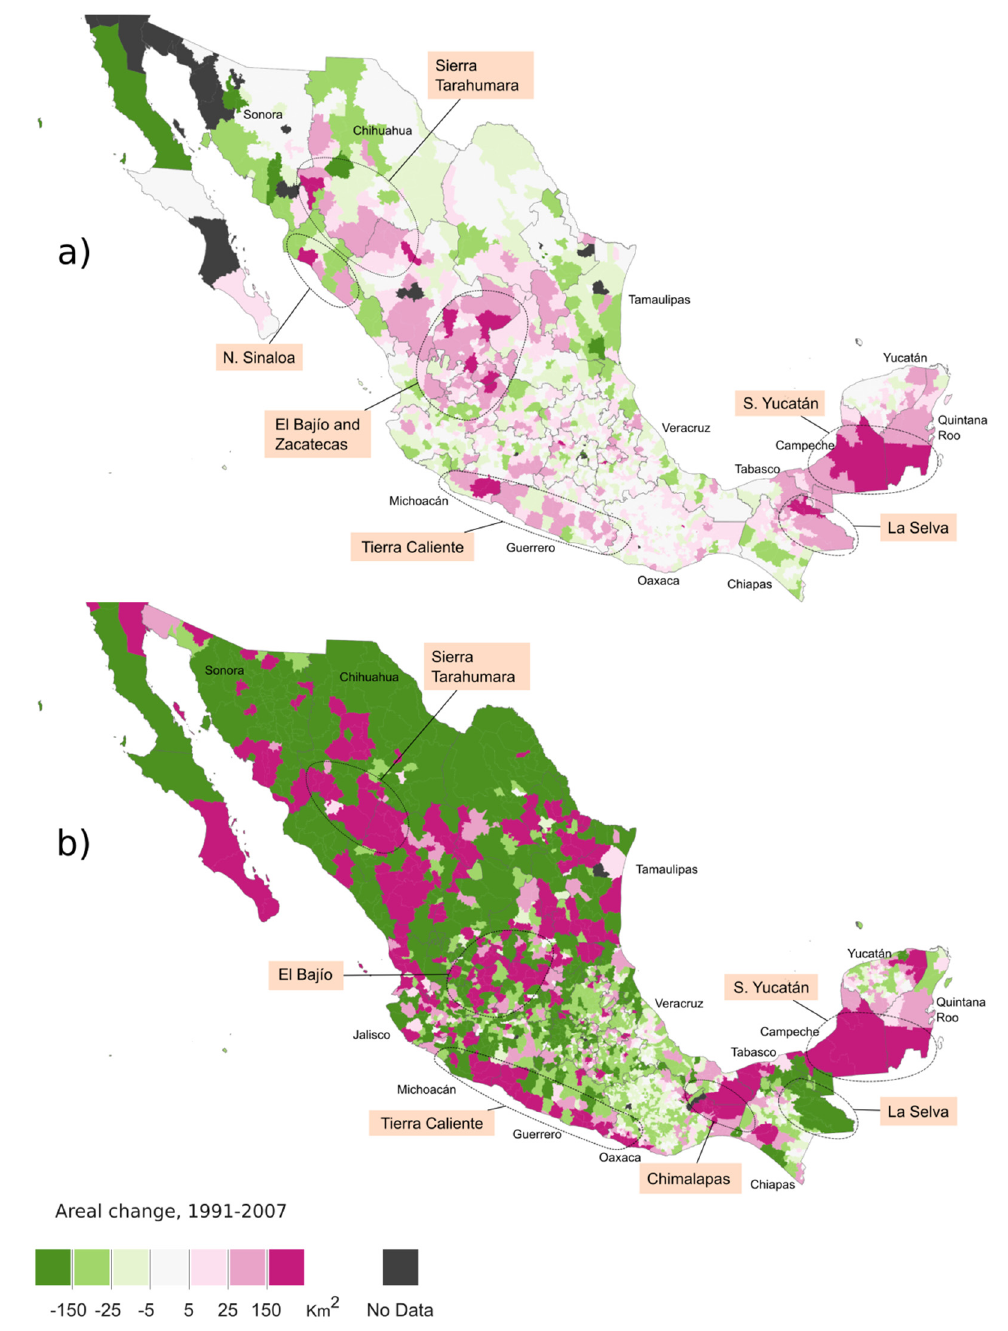
Figure 3. ( a ) Change in maize cropland and ( b ) grazing area for cattle per municipio . Grazing area was calculated multiplying animal inventories by regional stocking